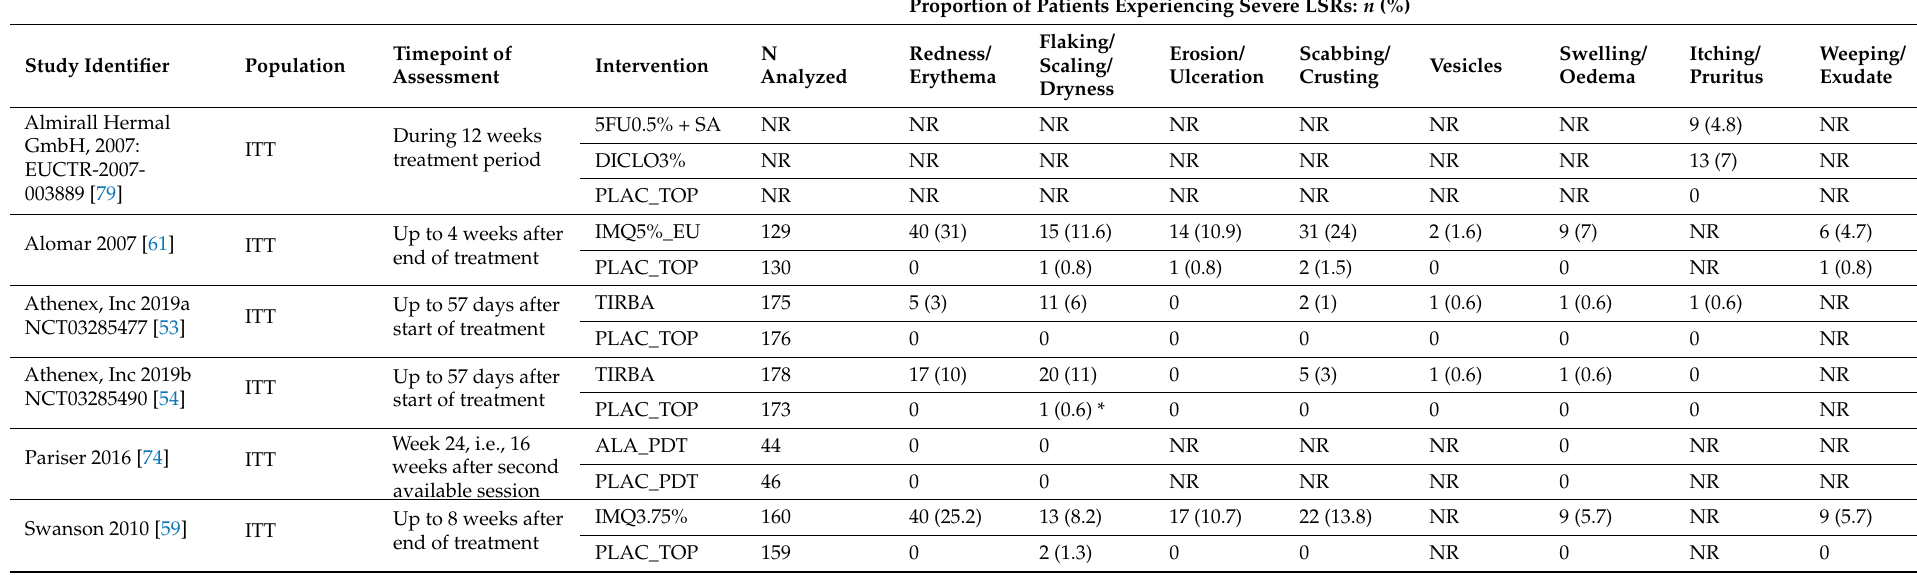
Table 3. Patients experiencing severe